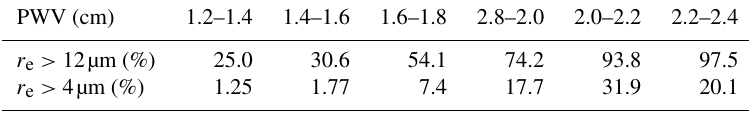
Table 2. Occurrence frequencies of large in-cloud r e ∗ under relatively high PWV